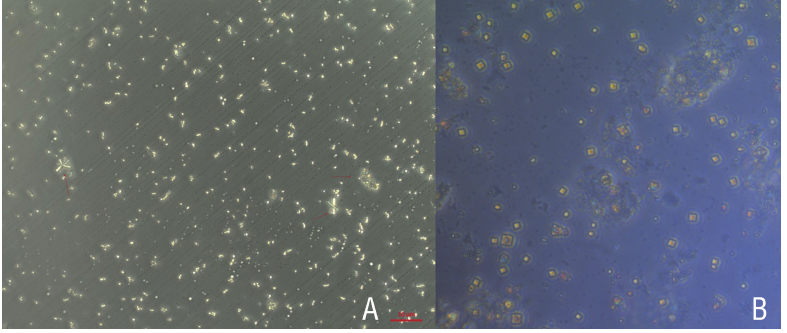
Figure 1 - Calcium oxalate crystal morphologies representing the type of crystal in a buffer and in b urine at 40 X